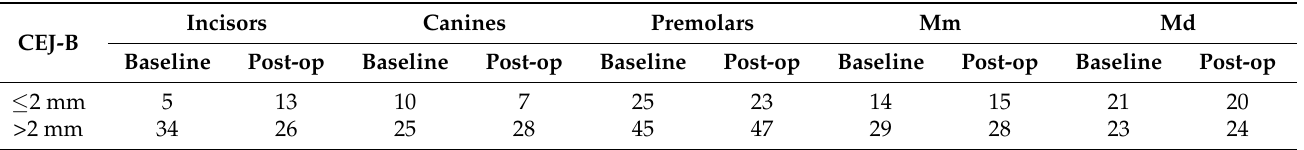
Table 1. Root distribution depending on the distance between the buccal bone plate margin and CEJ (CEJ-B) before and after orthodontic treatment (Mm, mesial root of molar; Md, distal root of molar). Incisors CEJ-B